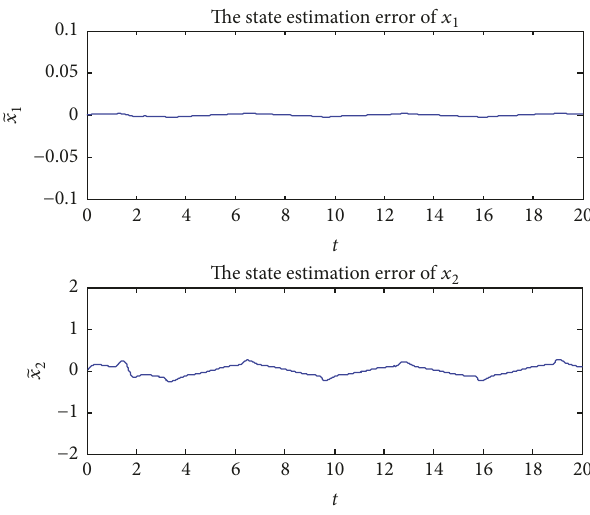
Figure 1: State estimation errors for 𝑓 1 (𝑡)